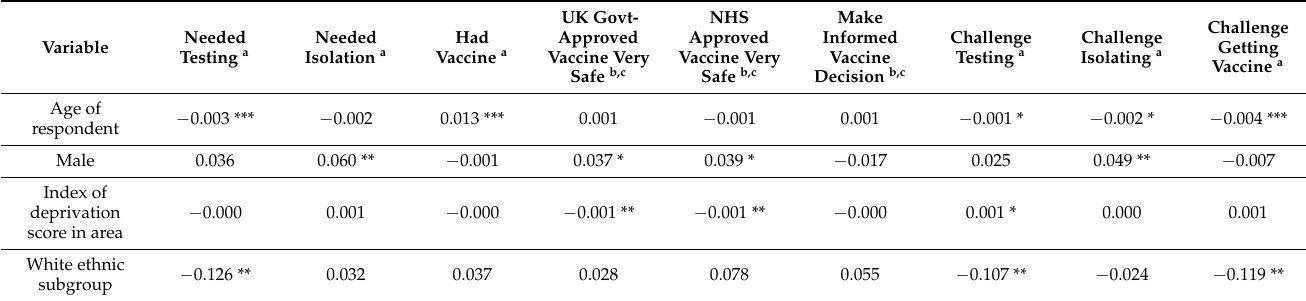
Table 2. (Weighted) marginal effects ( ∂ ˆ p / ∂ x ) from the regression